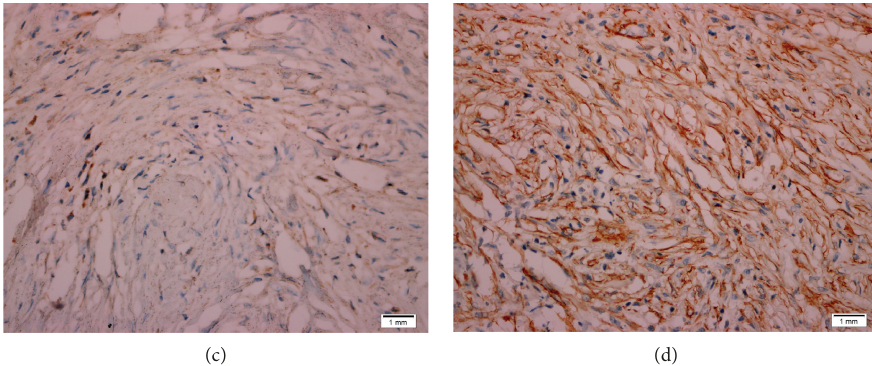
Figure 2: Histopathological examination of the mass revealed (a) 100x microscopic image showing spindle cells proliferation, forming fascicles and whorls on a background of collagen fibres, and (b) 200x microscopic image showing mixed inflammatory cells infiltration in the background including plasma cells and eosinophils. (c) Spindle cells are focally positive for anaplastic lymphoma kinase (ALK) by im- munohistochemistry. (d) Spindle cells are diffusely positive for smooth muscle actin (SMA) by